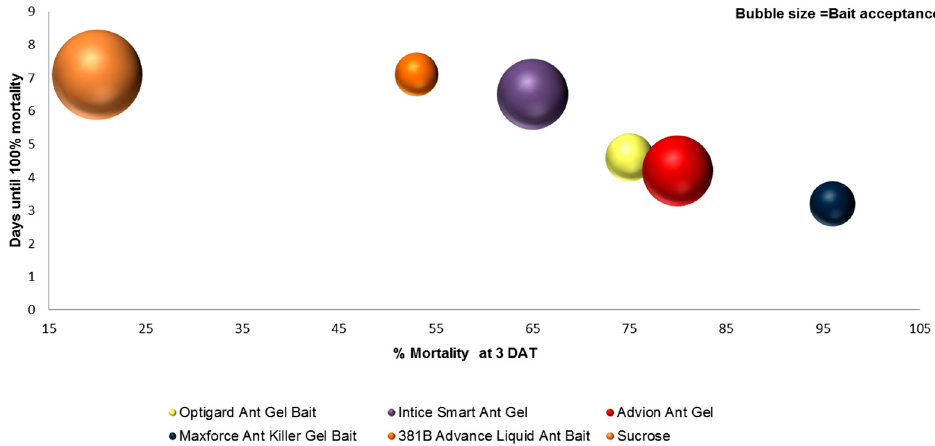
Figure 7. Laboratory assay results for bait performance criteria of acceptance, days until 100% mortality, and percent mortality at 3 DAT for commercially available liquid or gel ant baits combined into a single graph to allow direct comparisons. Baits indicated by bubbles in lower, right quadrant and with largest diameter are those with highest mortality at 3 DAT, fewest days to 100% mortality, and highest acceptance. Sucrose control is burnt orange, top left corner.